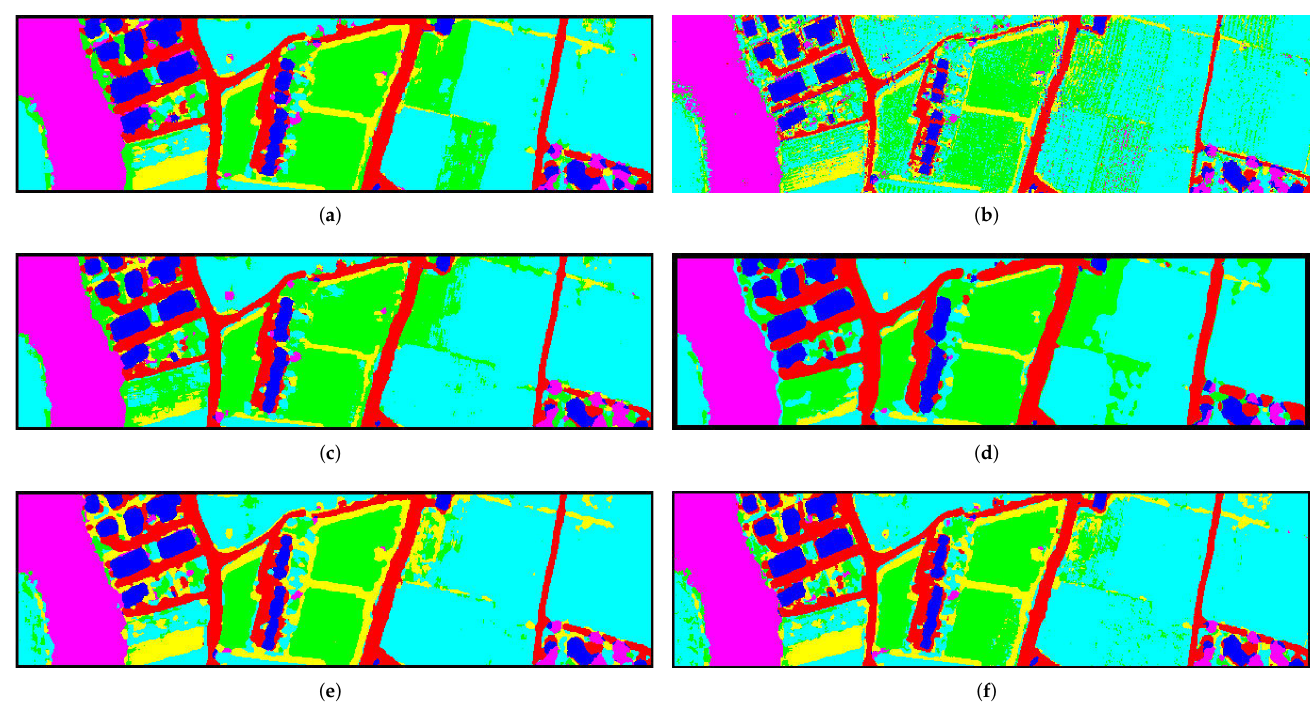
Figure 10. Classification maps of the Trento data using different models. ( a ) Two-branch. ( b ) EndNet.